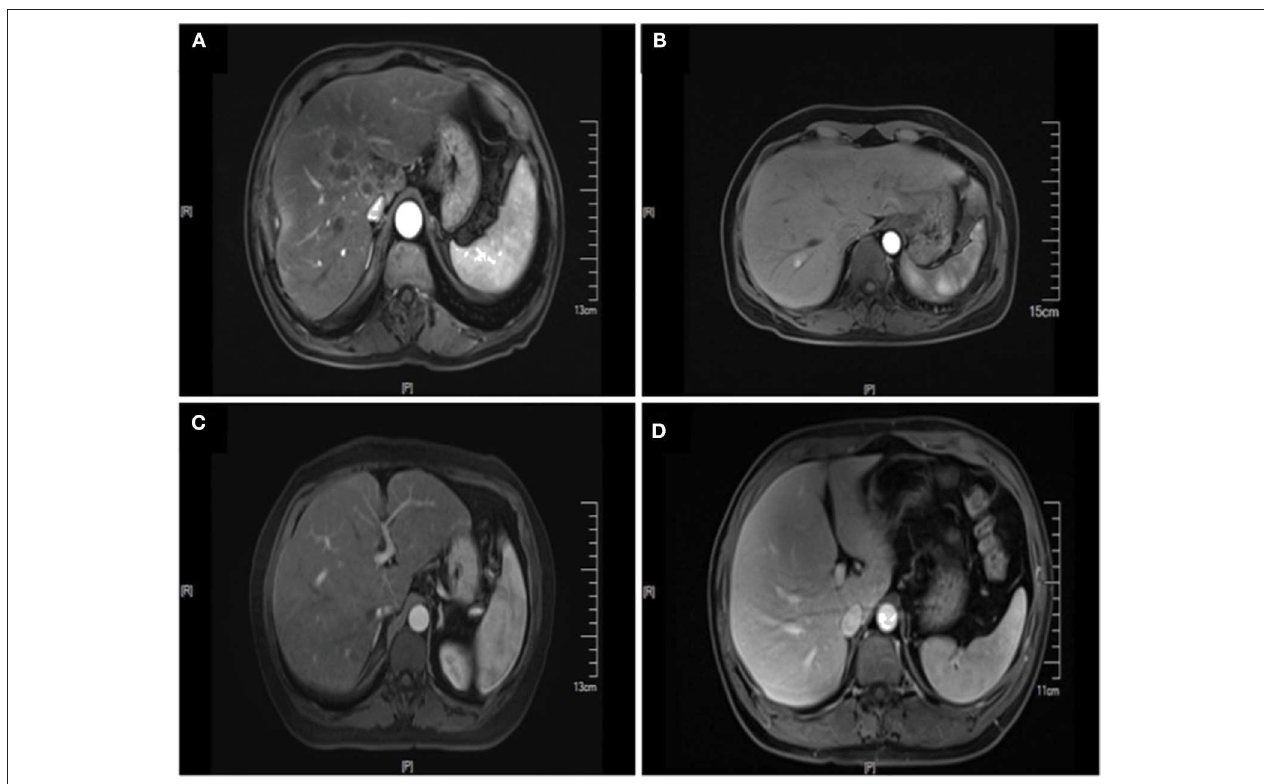
FIGURE 2 | Enhanced MRI images of liver metastasis, NAFLD and normal liver in the CRC patients. (A) NAFLD group, synCRLM + : The density of liver parenchyma decreased significantly in the reverse position. Multiple patchy abnormal signal shadows were seen in the liver, especially in the hepatic hilum. Necrosis was observed in the center of some lesions, with low enhancement in the center of the enhanced lesions and line-like enhancement at the edges. (B) Control group (without NAFLD), synCRLM + : Enhanced scan showed a round-like long T1 and long T2 signal shadow near the right hepatic vein in the right posterior lobe of the liver. In the arterial phase, the lesion was significantly enhanced, and the surrounding areas could be seen with enhanced flocculent perfusion. (C) NAFLD group, synCRLM − : The density of liver parenchyma decreased significantly in the reverse position. (D) Control group (without NAFLD), synCRLM − : The liver was in regular shape, and the proportion of each lobe was harmonious. No obvious abnormal signal shadow was observed in the liver